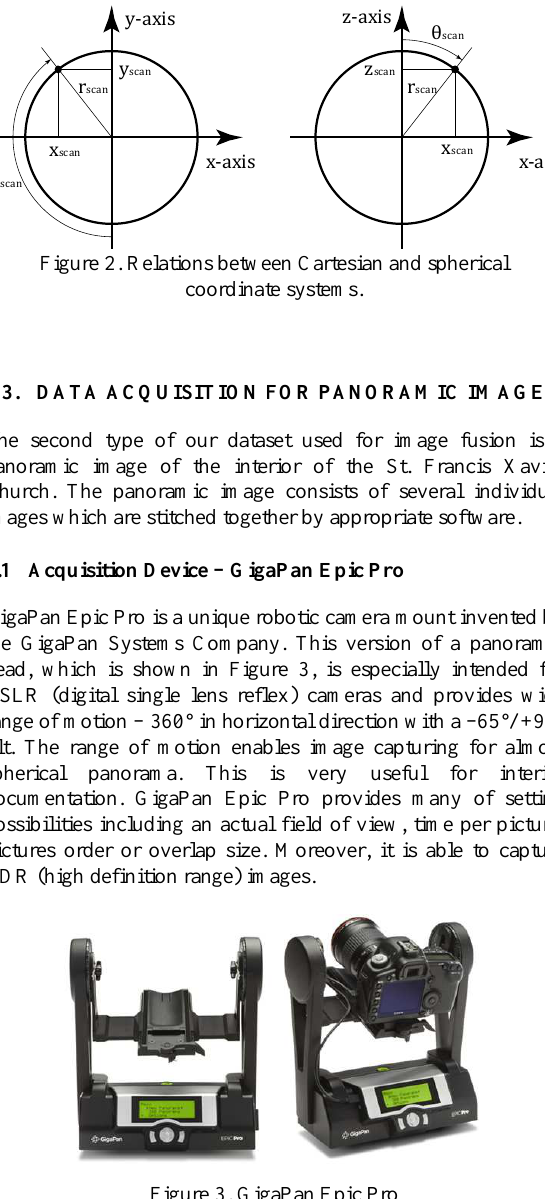
Figure 3. GigaPan Epic